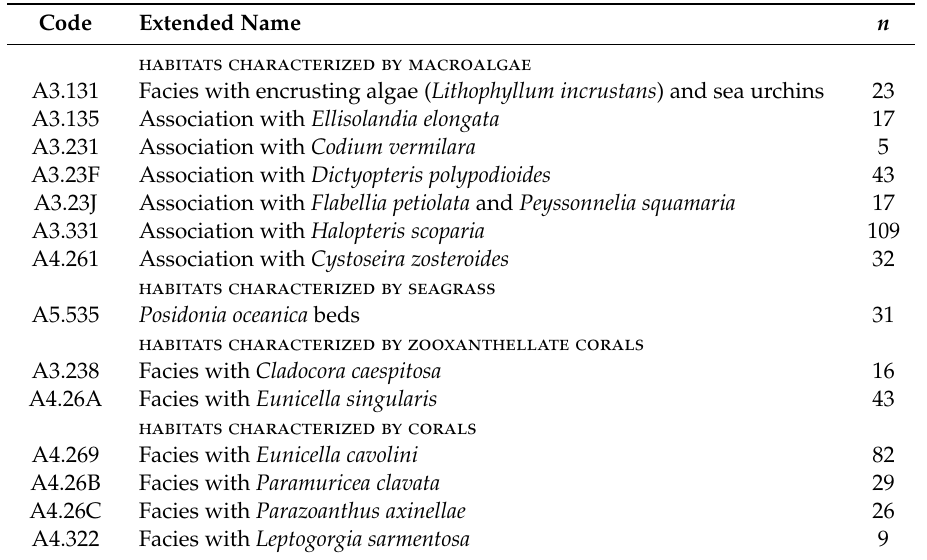
Table 1. EUNIS habitats recognized in the rocky reefs of Portofino MPA between 1 m and 45 m depth. Here, n is the number of samples belonging to a specific EUNIS habitat. Where necessary (e.g., nomenclatural updates), extended names have been emended with respect to the original ones.